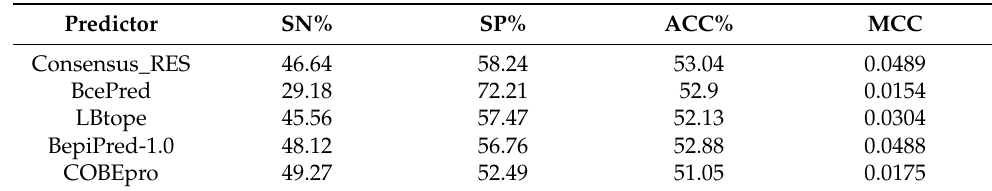
Table 7. Performance of “per residue” predictors. The methods are tested against the Consensus_NR data